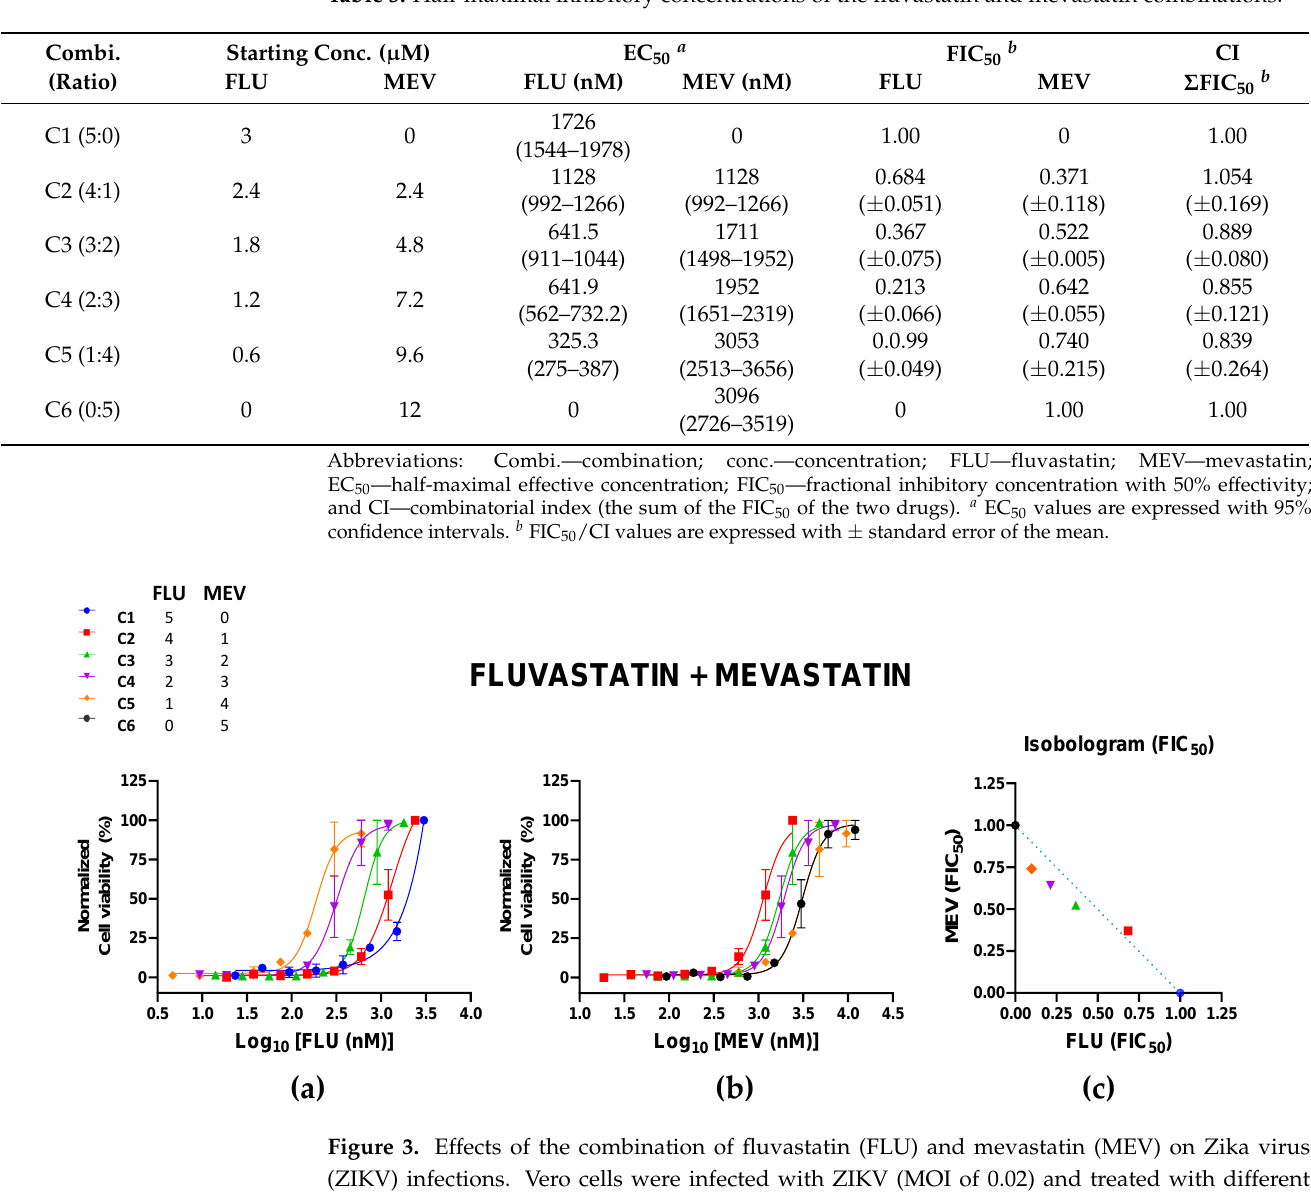
Table 3. Half-maximal inhibitory concentrations of the fluvastatin and mevastatin combinations. Combi.